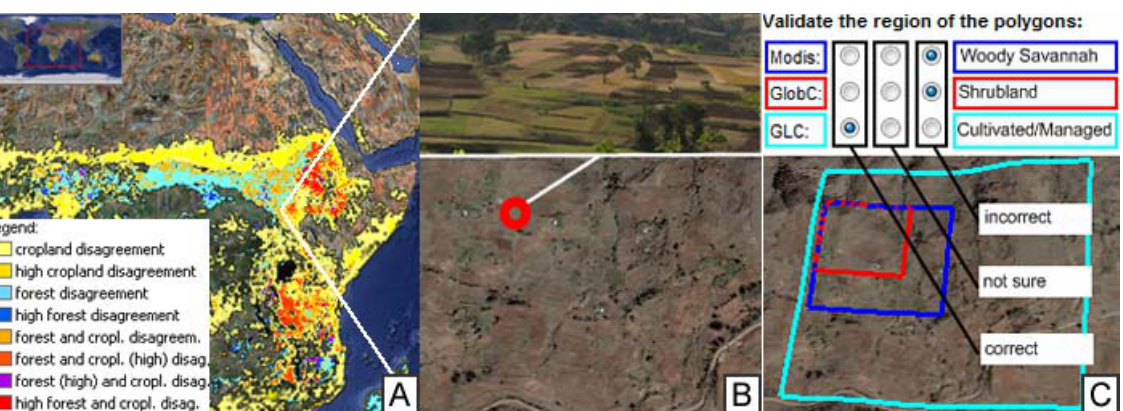
Figure 2. (A) The geo-wiki.org – volunteers have the ability to view both cropland and forest disagreement maps derived from three recent global land cover datasets GLC-2000, MODIS and GlobCover, (B) select and visualize with the help of Google Earth available high resolution images as well as upload or view geo-tagged field pictures (e.g., from Panoramio.com, Confluence.org), and (C) determine which land cover type is found on the ground and decide which dataset is correct, incorrect or if the validater is not sure. Results are recorded in a spatial